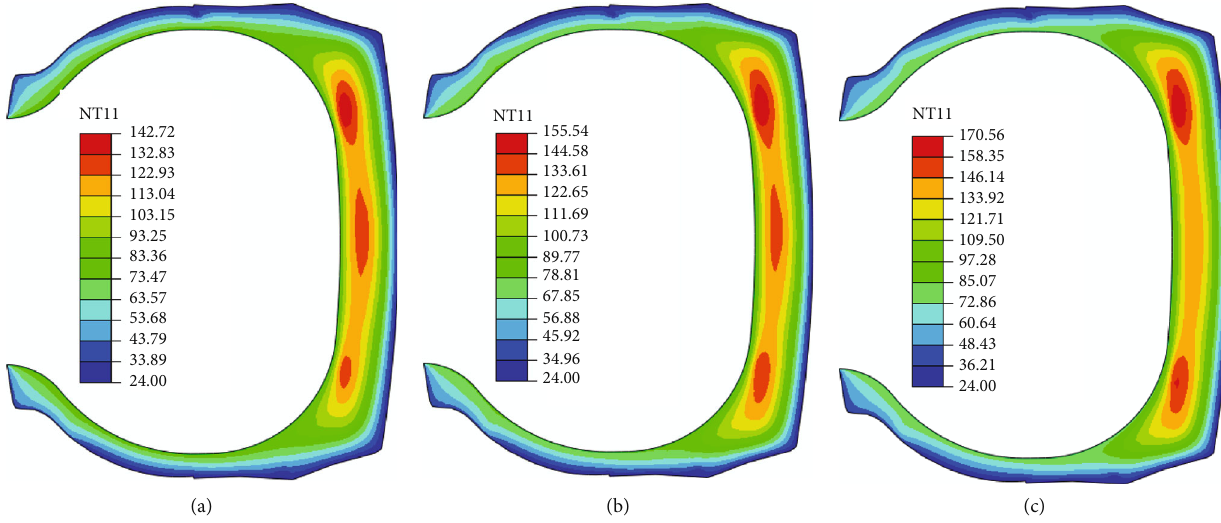
Figure 15: Temperature fi eld distribution of a tire at a speed of 22.5km/h: (a) 0.6MPa in fl ation pressure and 46667kg load (working Condition (7)), (b) 0.5MPa in fl ation pressure and 55000 kg load (working Condition (2)), and (c) 0.55MPa in fl ation pressure and 63333kg load (working Condition (6)). Table 9: Analysis of the range of maximum tire temperatures ( ° C). Indicators